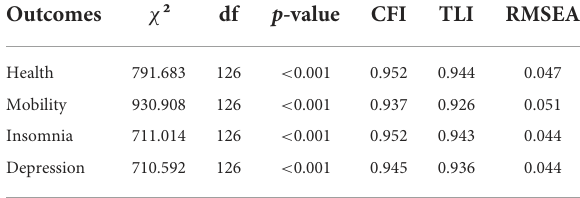
TABLE 3 Model fits of mediating models with the four